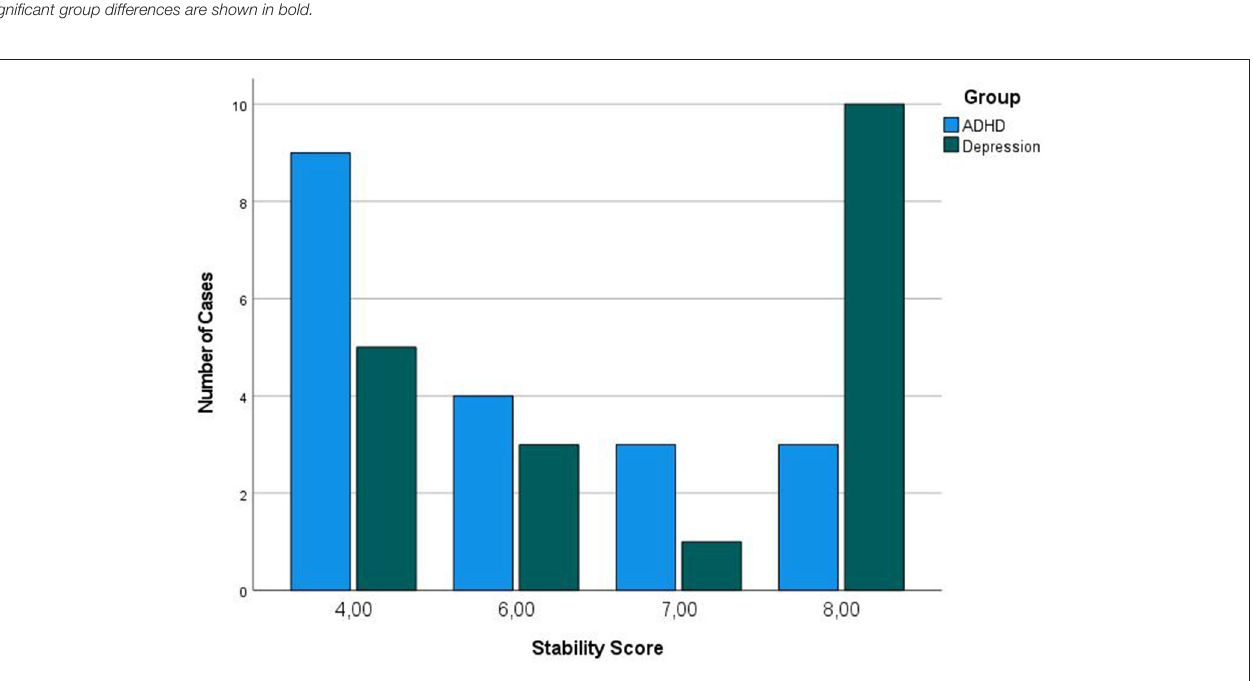
10.9, df 3, p 0.012. = = =